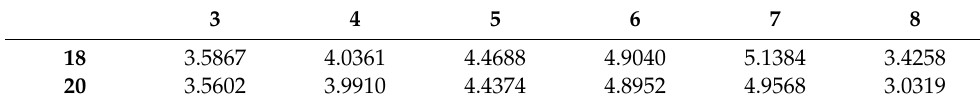
Table 7. The ef f ( j , k ) value of the Reverse Biorthogonal Spline family (wavelet length 18–20). 3